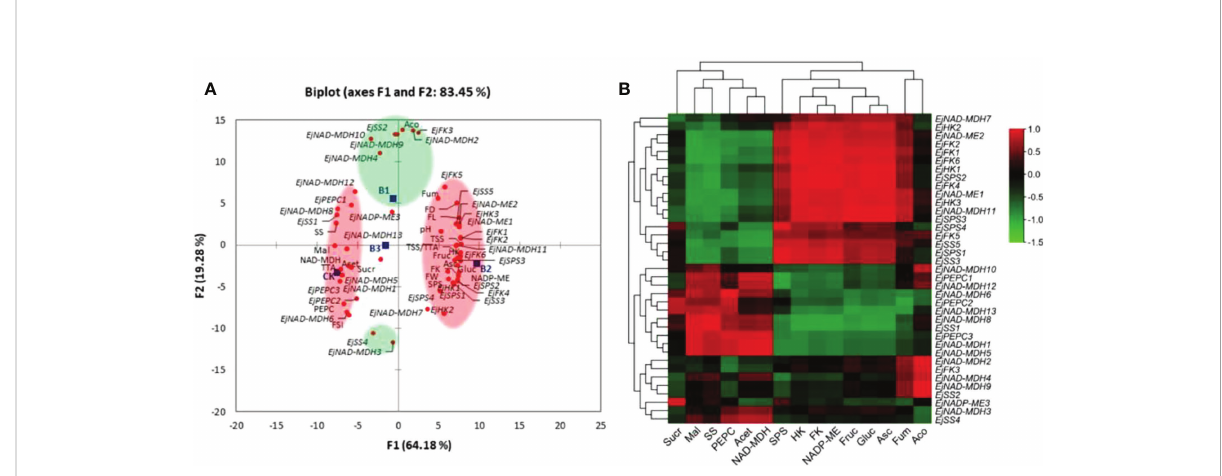
FIGURE 9 (A) Principal component analysis (PCA)among B treatments and sugar-acid attributes of loquat. Clustering of B treatments and measured attributes into groups (coloured circles) is based on their highest squared cosine values corresponding to the factor, F1 (red) or F2 (green). (B) Pearson ( n ) correlation analysis between “ sugar-acid pro fi le and key enzymes involved in their metabolism ” and “ relative expressions of related genes ” in fruit pulp of loquat. CK, control; B1, 0.1% borax; B2, 0.2% borax; B3, 0.3% borax; FW, fruit weight; FL, fruit length; FD, fruit diameter; FSI, fruit shape index; TSS, soluble solid contents; TTA, total titratable acidity; TSS/TTA, sugar-acid ratio; pH, fruit juice pH; Fruc, fruit fructose; Gluc, fruit glucose; Sucr, fruit sucrose; SPS, sucrose-phosphate synthase; SS, sucrose synthase; HK, Hexokinase; FK,